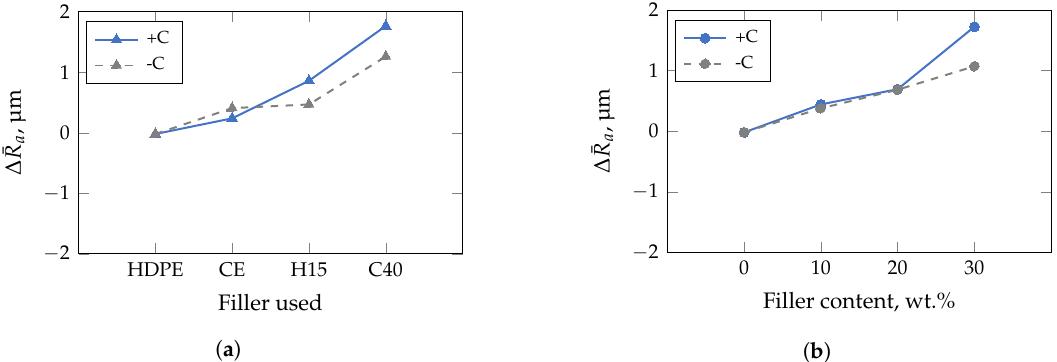
Figure 9. Results of multivariate analysis of variance performed with a confidence interval of 95% for insert with low roughness. Compatibilizer dependence is marked with +C (with), and − C (without). ( a ) An increasing filler diameter ( D 50-value) of filler CalPlex Extra (CE), Plustalc H15 (H15), and CalPlex 40 (C40) decreases the impression quality (higher ∆ ¯ R a -value). ( b ) Filler and compatibilizer content influences the impression quality (higher